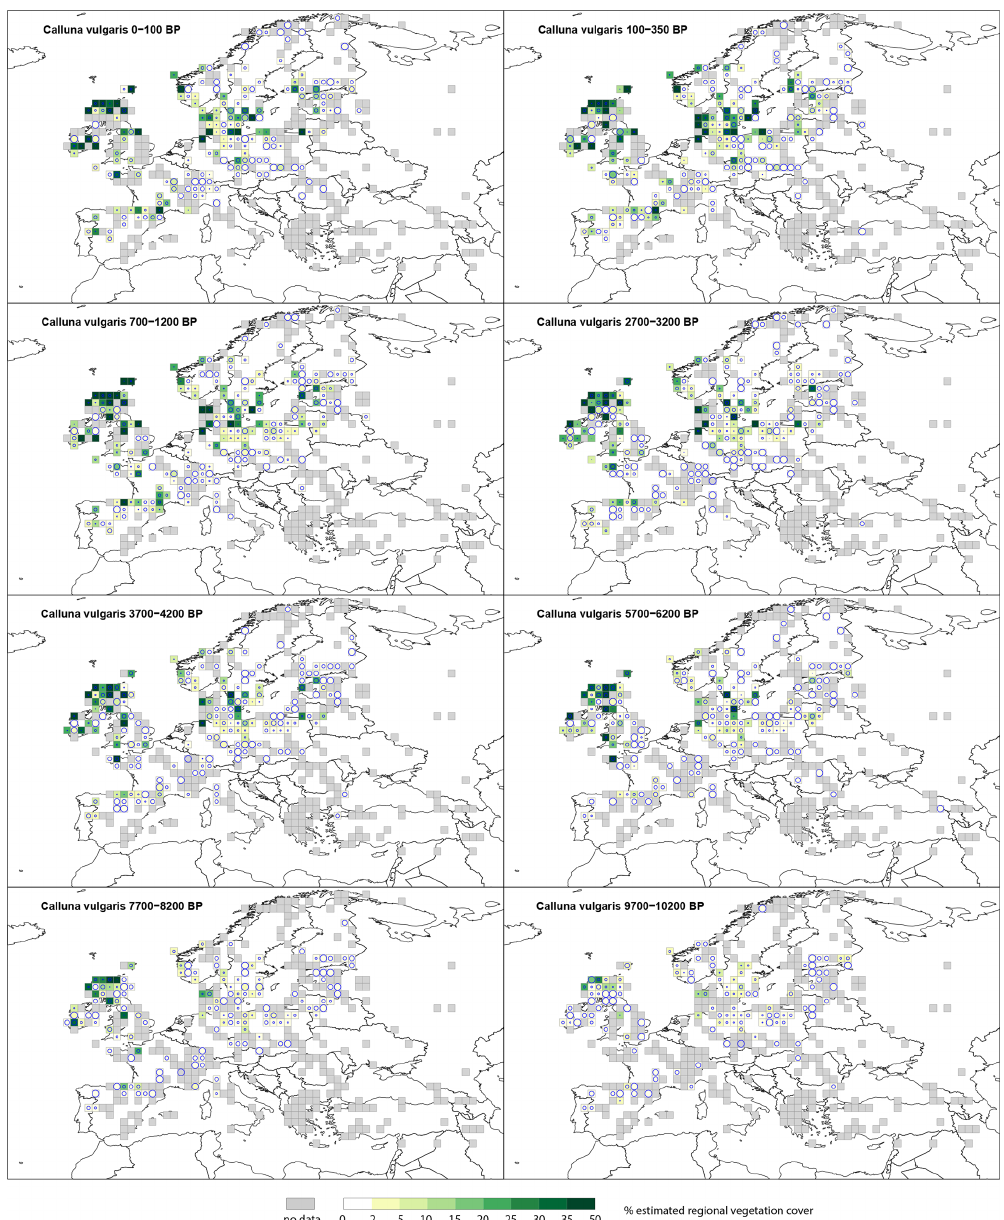
Figure D1. Grid-based REVEALS estimates of Calluna vulgaris cover for eight Holocene time windows. Percentage cover in 2% intervals between 0% and 2%, 3% intervals between 2% and 5%, 5% intervals between 5% and 35%, and 15% intervals between 35% and 50%. Intervals represented by increasingly darker shades of green from 5%–10%. Grey grid cells have no data (pollen) for Calluna vulgaris in the mapped time window. The circles represent the coefficient of variation (CV; the standard error divided by the REVEALS estimate). When SE ≥ REVEALS estimate, the circle fills the entire grid cell, and the REVEALS estimate is not different from zero. This occurs mainly where REVEALS estimates are